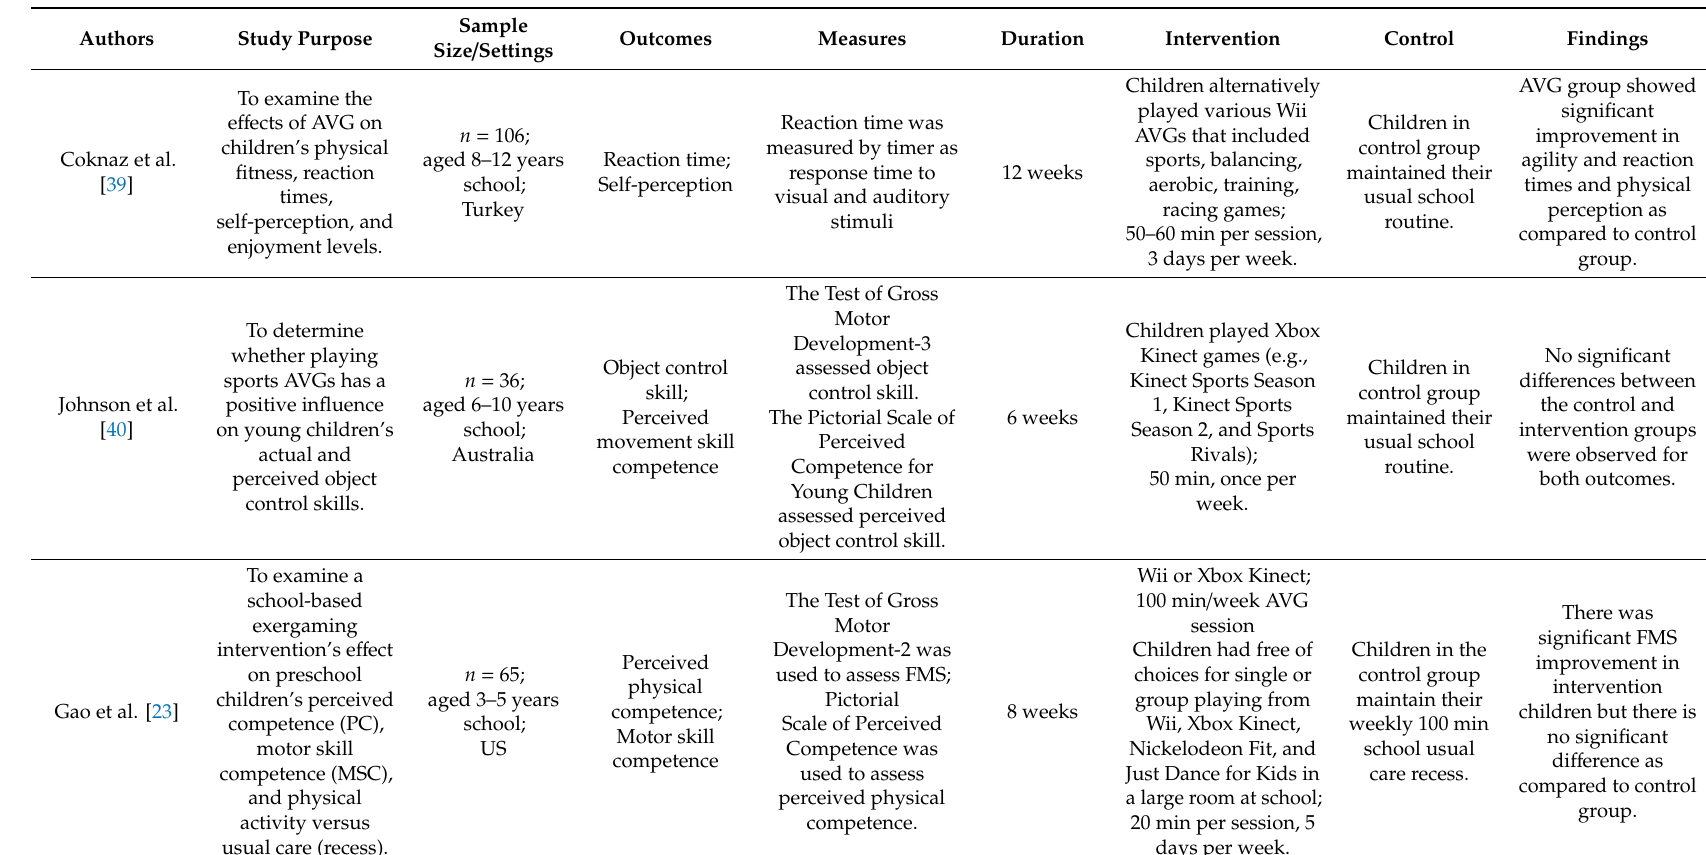
Table A1. Descriptive characteristics of included